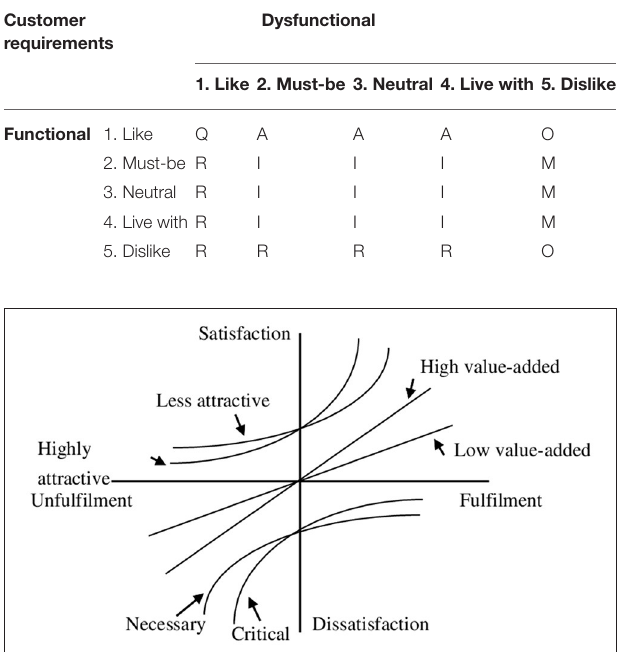
FIGURE 3 | Refined Kano model of quality attributes